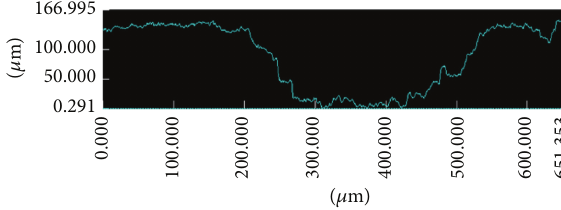
Figure 5: The cross section of crater in boron target ablated with 1064 nm wavelength after 50 laser